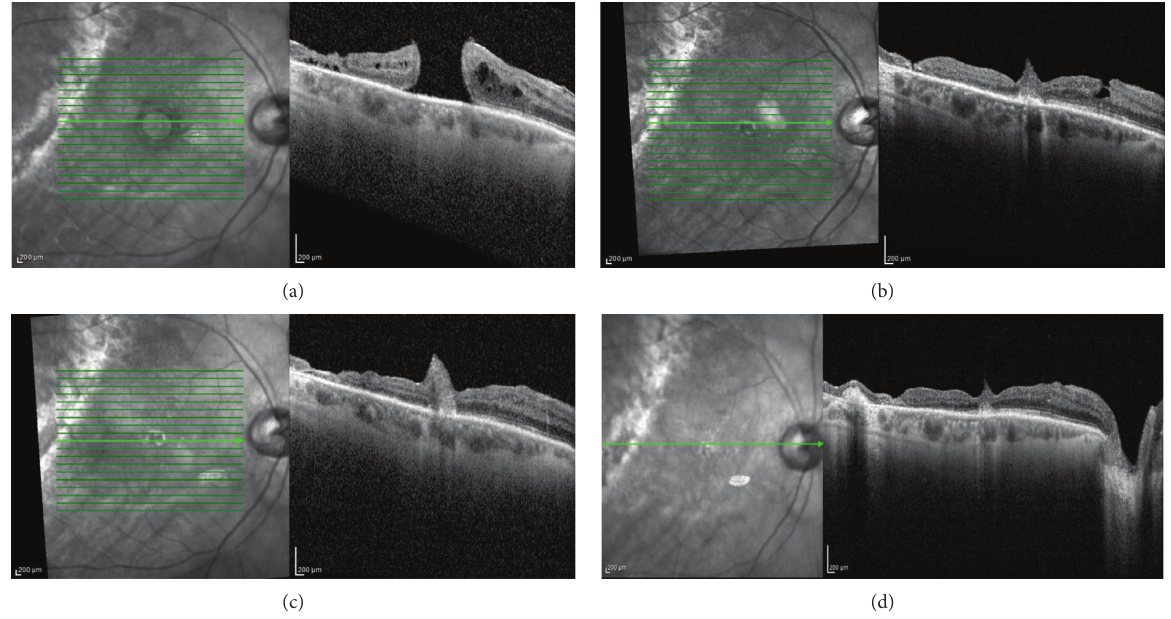
Figure 5: Macular hole closure over time after posterior lens capsular flap transplantation. Vertical SD-OCT scans: (a) baseline, (b) one month after surgery, (c) six months postoperatively, and (d) 12 months postoperatively. Scale bar � 200 µ